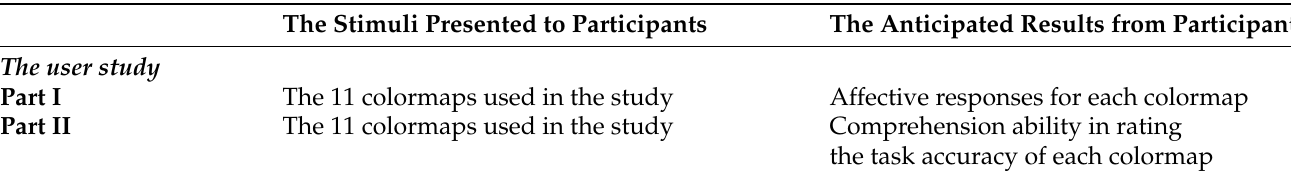
Table 1. The specification of the user study carried out, including the stimuli and the anticipated results. The Stimuli Presented to Participants The Anticipated Results from